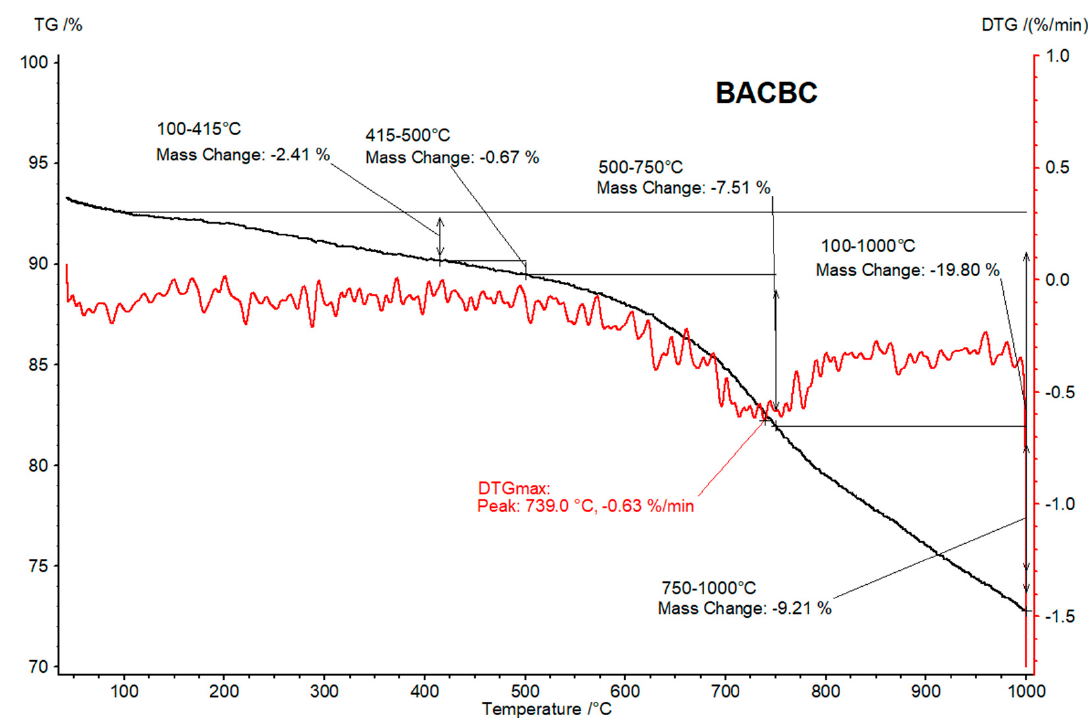
Figure A8. TG/DTG curves obtained for beech/alder chips biochar.